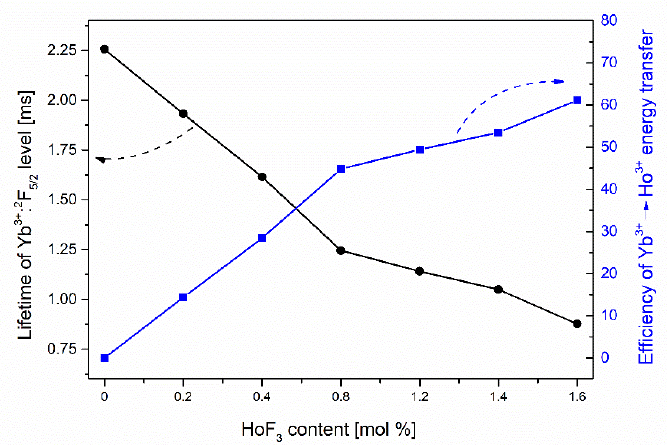
Figure 7. The Yb 3+ : 2 F 5/2 luminescence lifetime and the efficiency of the Yb 3+ → Ho 3+ energy transfer as a function of HoF 3 content.